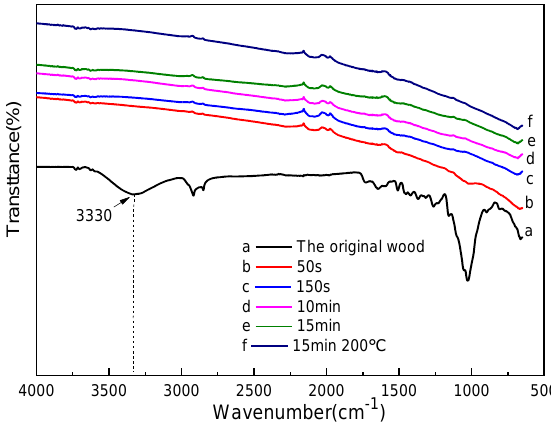
Figure 6. FTIR map of metallized wood veneer.